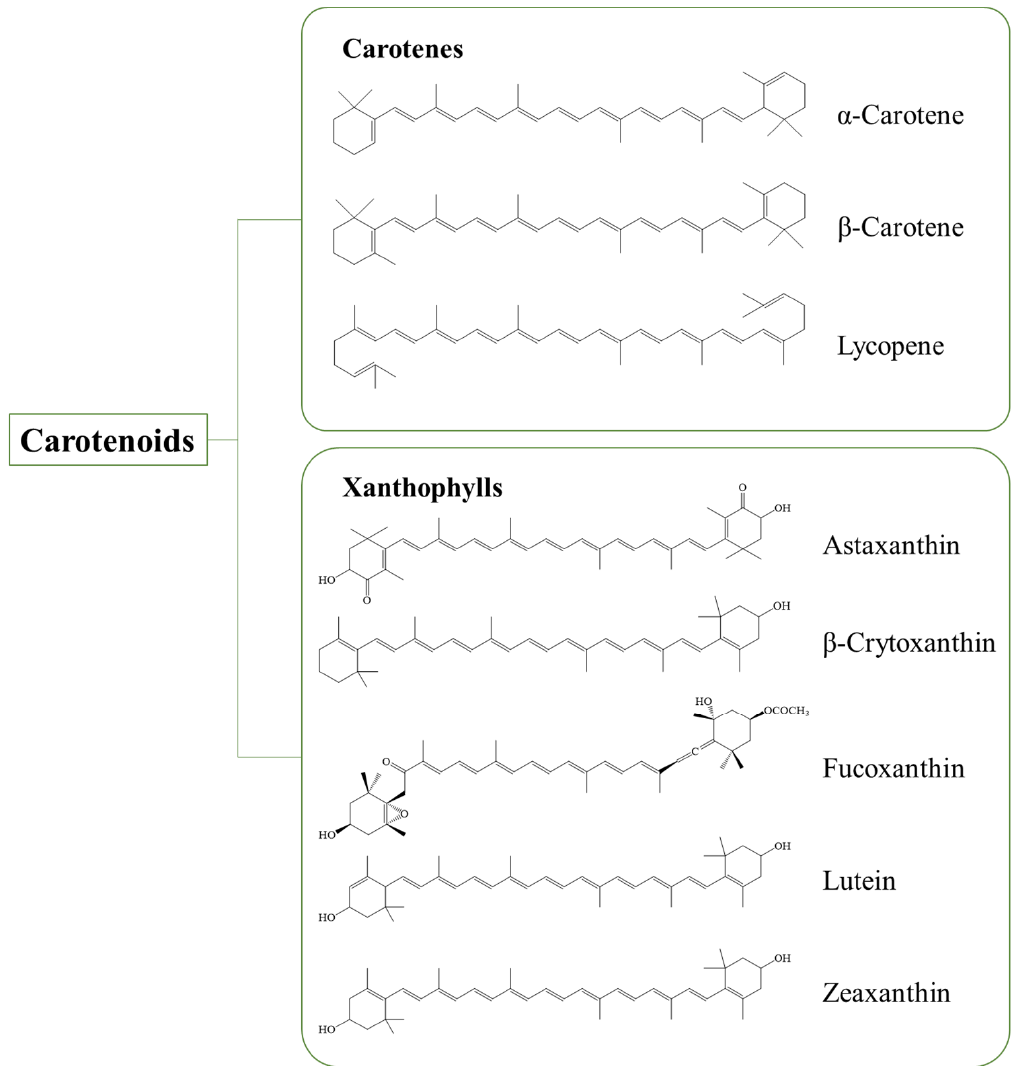
Figure 1. The structure of carotenes and xanthophylls.